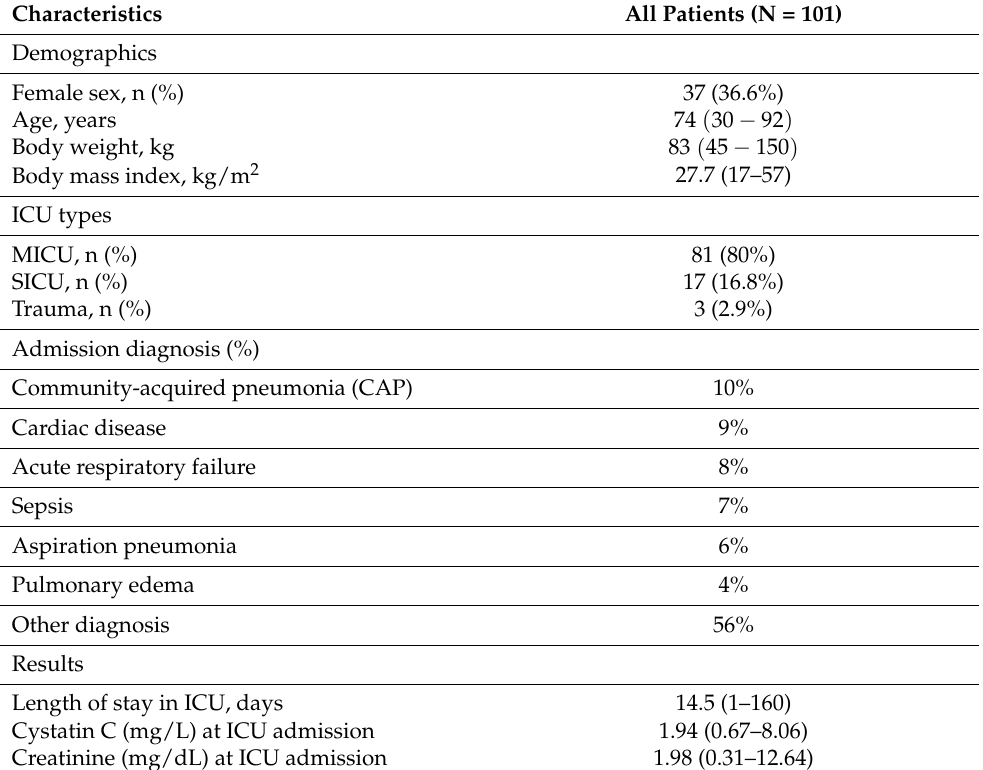
Table 1. Patient characteristics.